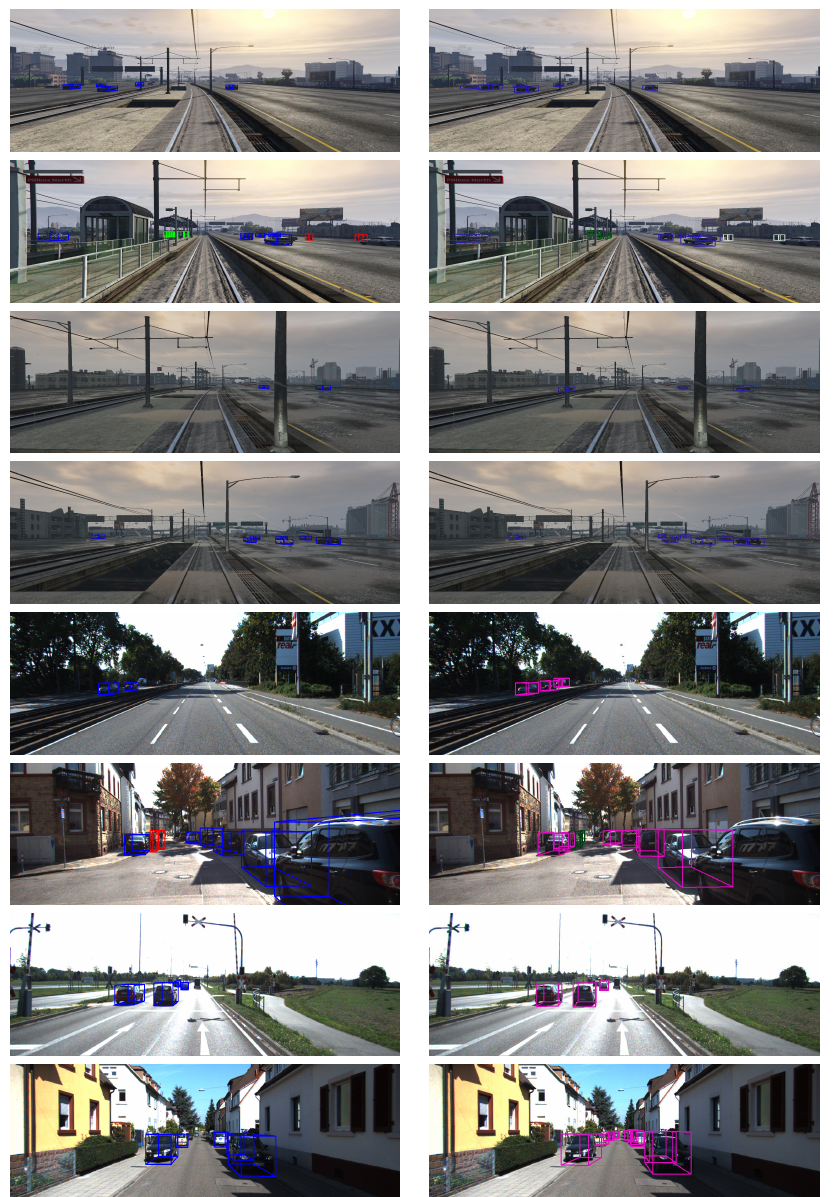
Figure 5. Qualitative results of our method were obtained through KITTI and our GTAV datasets. These images were extracted from the validation split of each dataset. The RoIs used for predicting the 3D bounding box parameters were computed through YOLOv3. 4 top lines: results obtained for GTAV dataset (left column: ground truth; right column: prediction), 4 bottom lines: results obtained for KITTI dataset (left column: ground truth; right column: